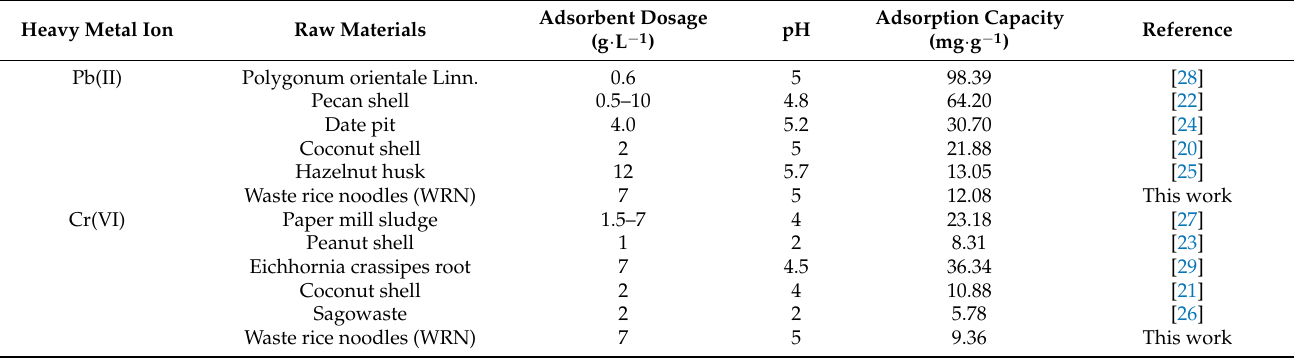
Table 4. Adsorption capacity of Pb(II) and Cr(VI) by AC with different low cost raw